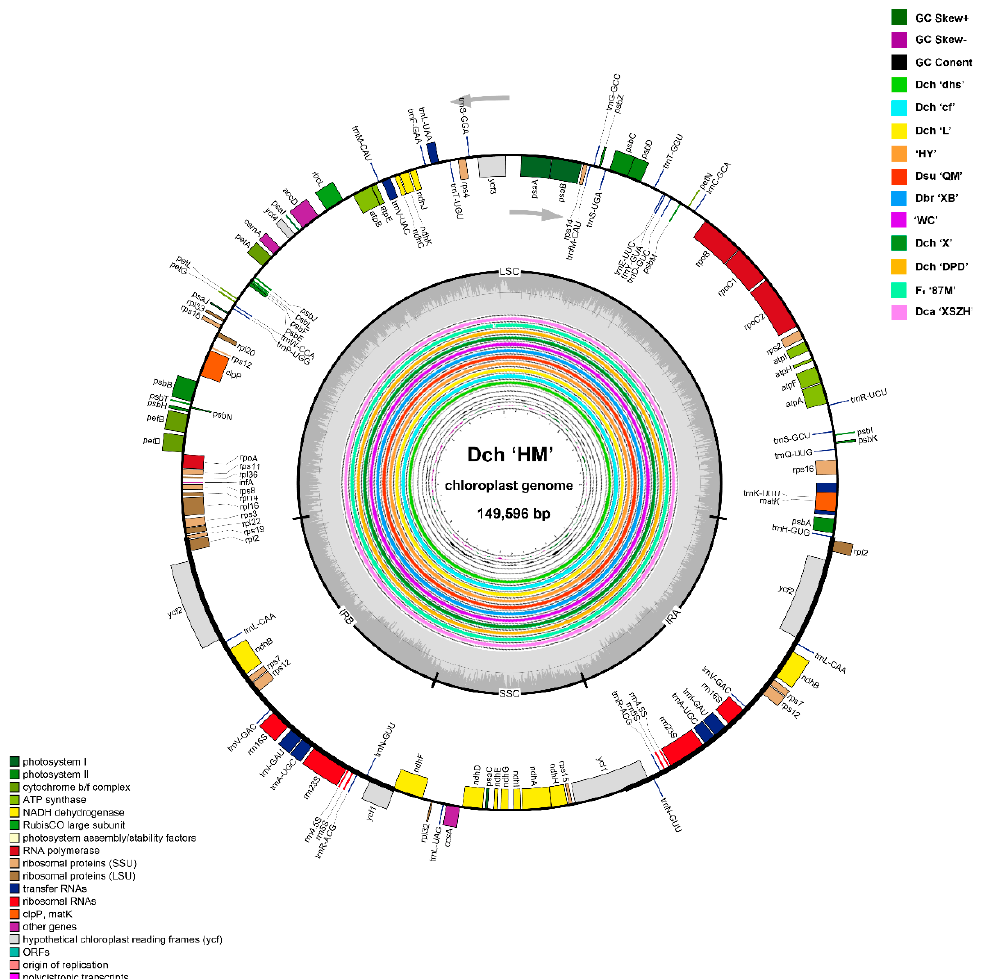
Figure 2. Chloroplast genome map of Dch ‘MH’ (the outermost three rings) and CGView [15] comparison of eleven Dianthus chloroplast genomes (the inter rings with different colors). Genes belonging to different functional groups are shown in different colors in the outermost first ring. Genes shown on the outside of the outermost first ring are transcribed counter-clockwise, and on the inside, clockwise. The gray arrowheads indicate the direction of the genes. The tRNA genes are indicated by one letter code of amino acids with anticodons. LSC, large single copy region; IR, inverted repeat; SSC, small single copy region. The innermost first black ring indicates the chloroplast genome size of Dch ‘MH’. The innermost second and third rings indicate GC skews and GC content deviations in the chloroplast genome of ‘MH’, respectively: GC Skew+ indicates G > C, and GC Skew– indicates G < C. From the innermost forth color ring to outwards 14th ring in turn: Dch ‘dhs’, Dch ‘cf’, Dch ‘L’, ‘HY’, Dsu ‘QM’, Dbr ‘XB’, ‘WC’, Dch ‘X’, Dch ‘DPD’, F 1 ‘87M’, Dch ‘L’, and Dch ‘XSZH’; chloroplast genome similar and highly divergent locations are represented by continuous and interrupted track lines, respectively.